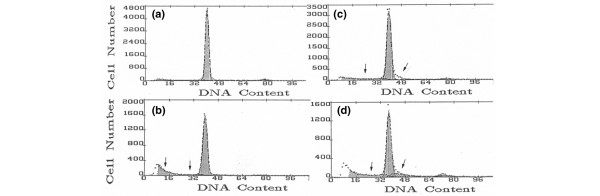
Effects of DHEA and DHEA8354 on the cell cycle. (a-c) Cell cycle distribution in MNU-induced mammary tumor of a control animal (a) and in an animal treated with dehydroepiandrosterone (DHEA) (b,c). Control tumors showed a low level of S-phase cells and a lack of cells with hypodiploid values of DNA. DHEA treatment induced an increase in apoptotic cells (b, arrow) and a decrease in G2M phase. A cell population is identified with DNA values after the G1/G0 peak (c, arrow), suggesting DNA abnormalities typical for senescent cells from another mammary tumor from an animal treated with DHEA. (d) DHEA induced both apoptosis and senescence (a small area after the G1/G0 peak (arrow), indicative of senescence.